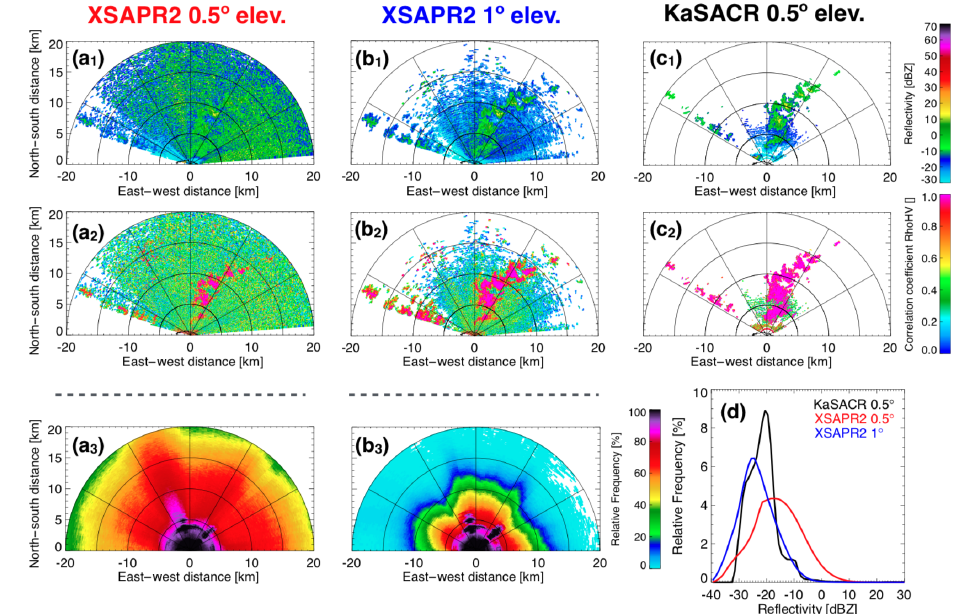
Figure 1. For significant echoes, (1) radar reflectivity, (2) correlation coefficient ( ρ HV ) and (3) relative frequency of occurrence of clutter as observed by the (a) XSAPR2 at 0.5 ◦ elevation, (b) XSAPR2 at 1 ◦ elevation and (c) KaSACR at 0.5 ◦ elevation. (d) Clutter characteristics estimated using 93h of clear sky